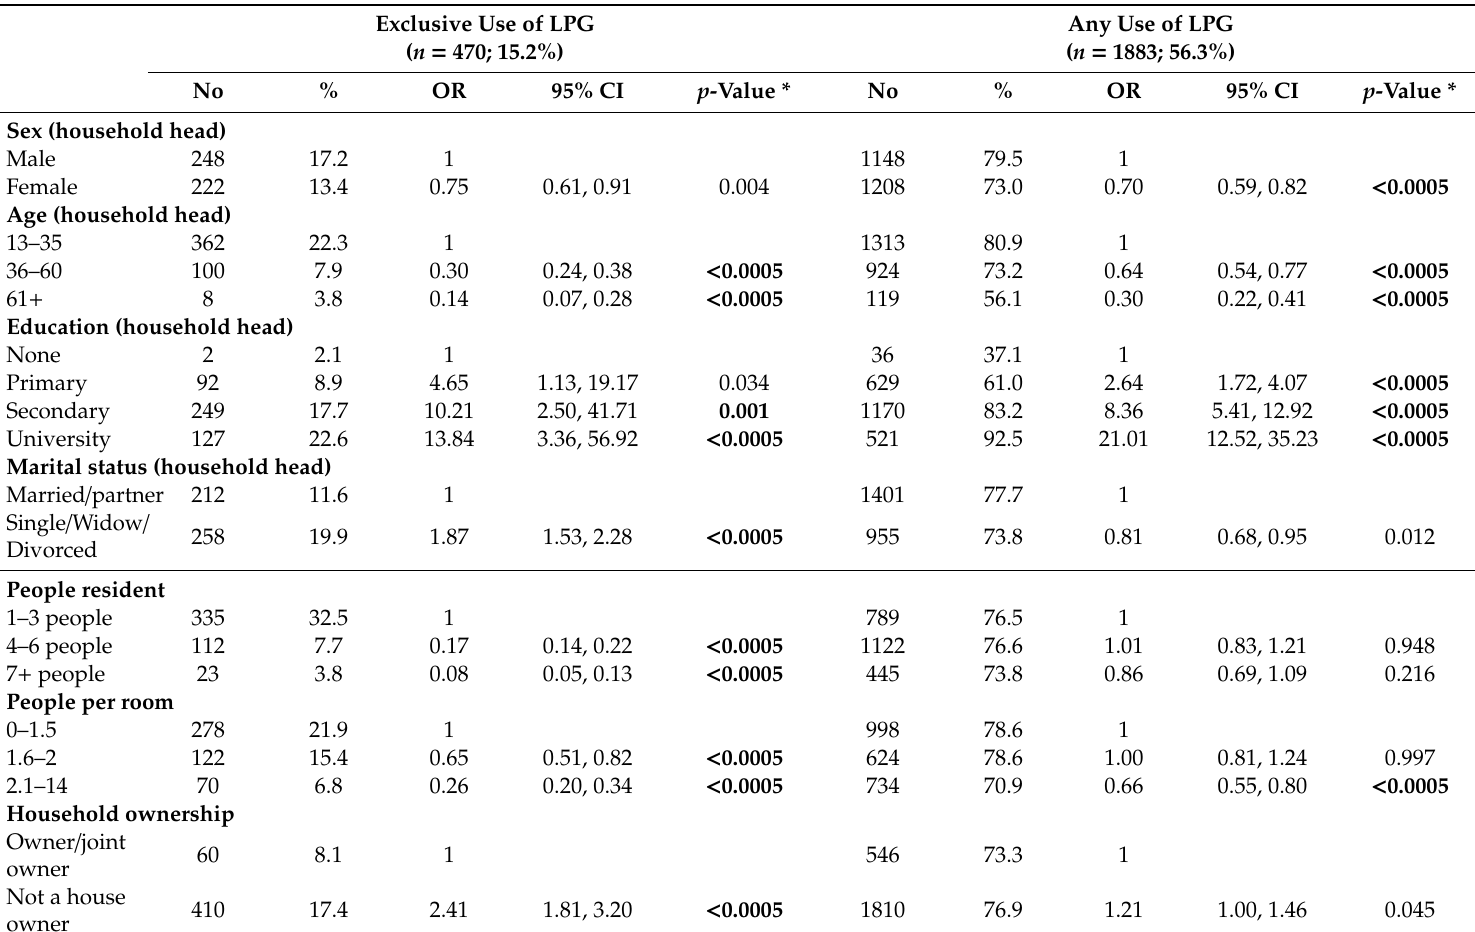
Table 8. Demographic / household factors associated with any and exclusive LPG use in peri-urban households (univariable analysis). Exclusive Use of LPG ( n = 470; 15.2%)